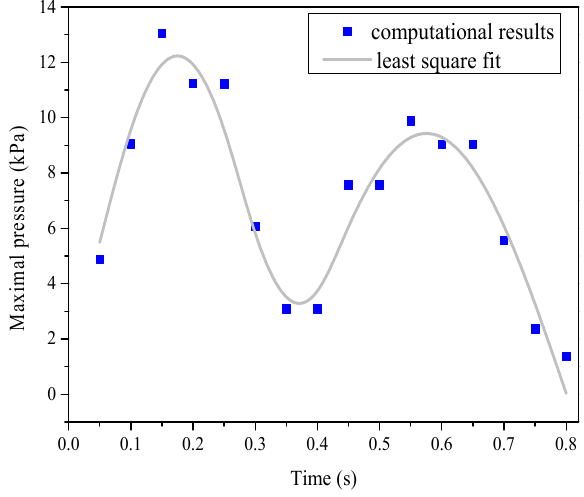
Figure 7. Temporal evolution of the maximal pressure.